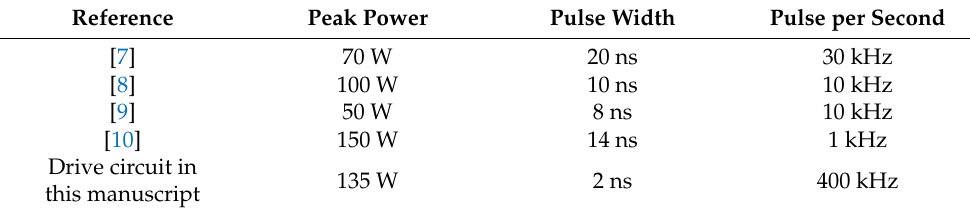
Table 1. Recent research results of semiconductor laser drive circuits.